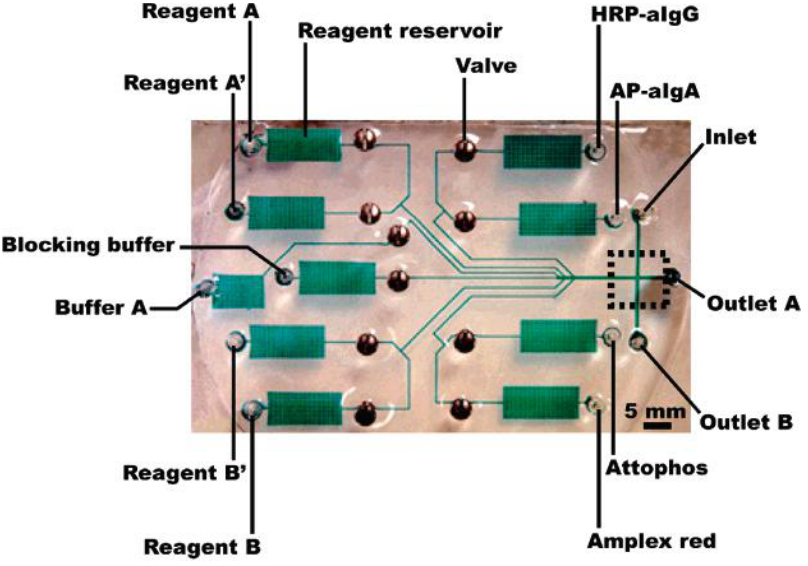
Figure 1. A lab-on-a-chip contains a network of channels and wells. Reprinted from [12] with permission © American Chemical